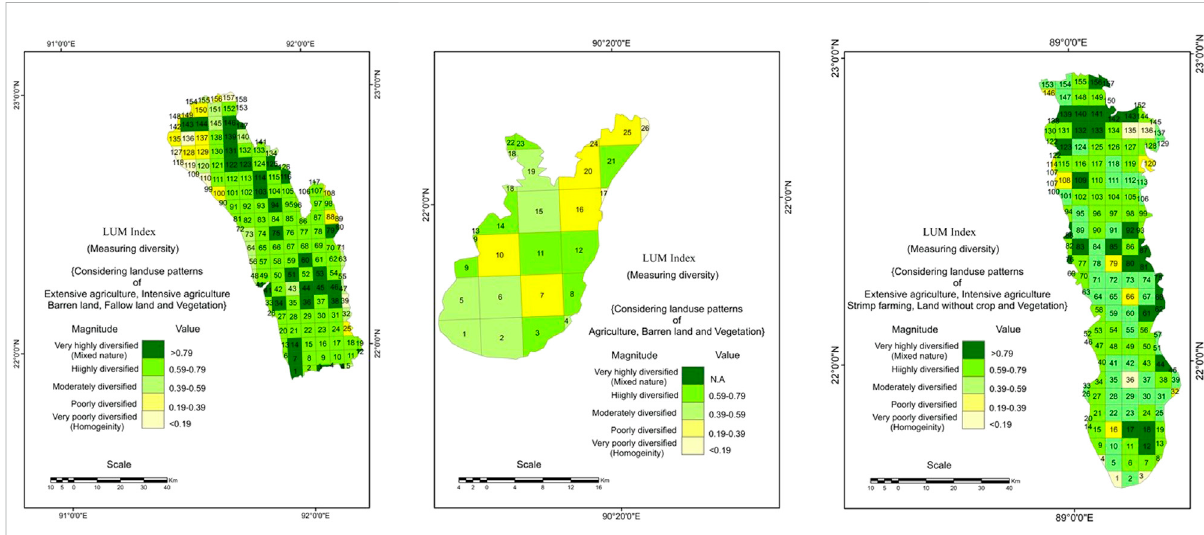
FIGURE 5 Calculated LUM index for measuring the diversity of 2019 considering the grid method; (A) in Chattogram, most of the areas are under highly diversi fi ed (0.59 – 0.79); (B) in Patuakhali, the area is poorly to moderately diversi fi ed because of its geographical location as it belongs to the coastal areaand%ofwastelandismaximumresultingthehomogeneouscharacter;and (C) inSatkhira,moderatelyandhighlydiversi fi edgridsaredominant.